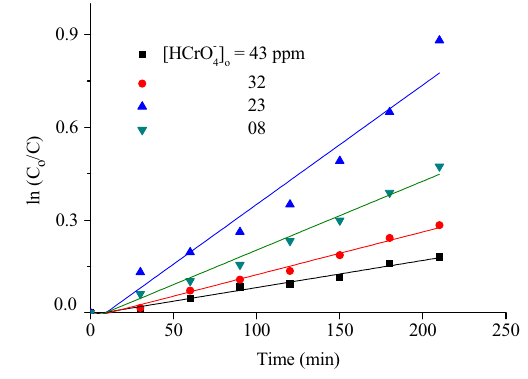
Fig. 8 The first-order kinetic model of ZnCo for the HCrO 4− reduction for various initial